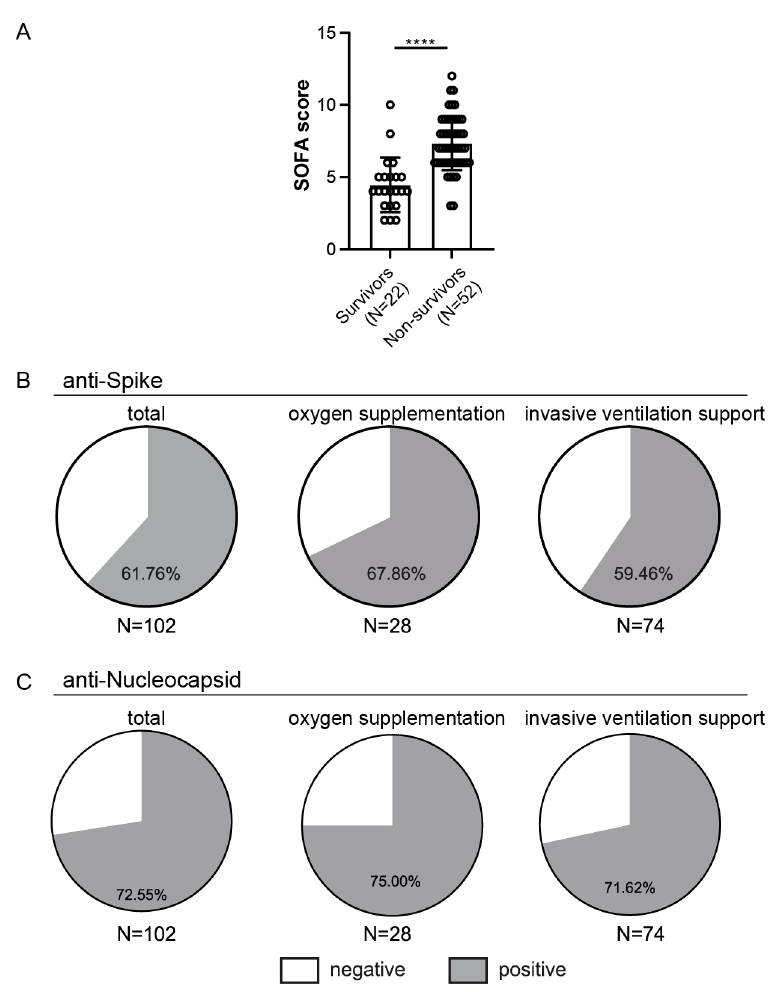
Figure 5. Outcome in relation to SOFA scores and rates of seroconversion in hospitalized patients.